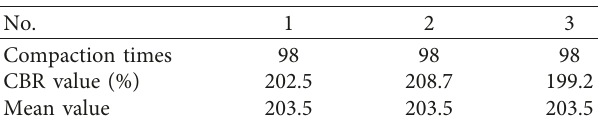
Figure 5: Relationship between penetration and clay subgrade depth. Table 3: CBR